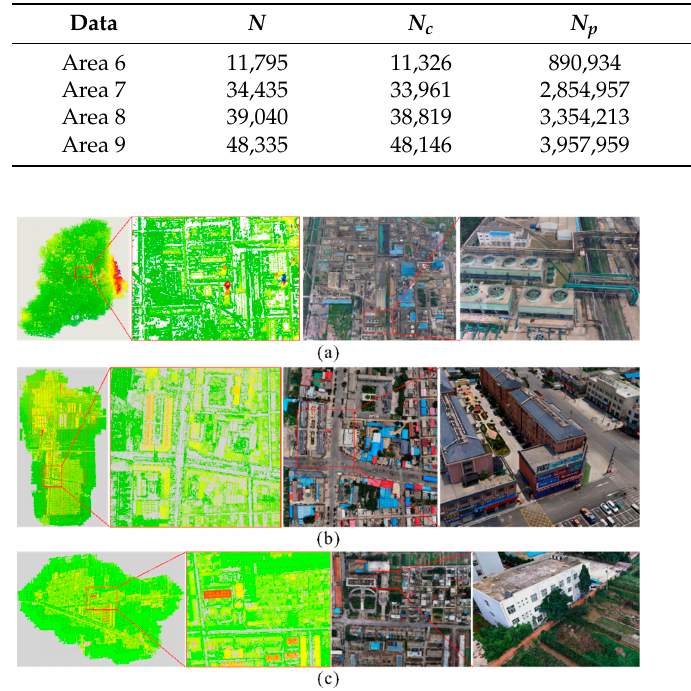
Table 9. Reconstruction results of the large-scale image dataset. ( N : number of images; N c : number of registered images; N p : number of structure points; Err : reprojection error (MSE); T : reconstruction time, in minutes).